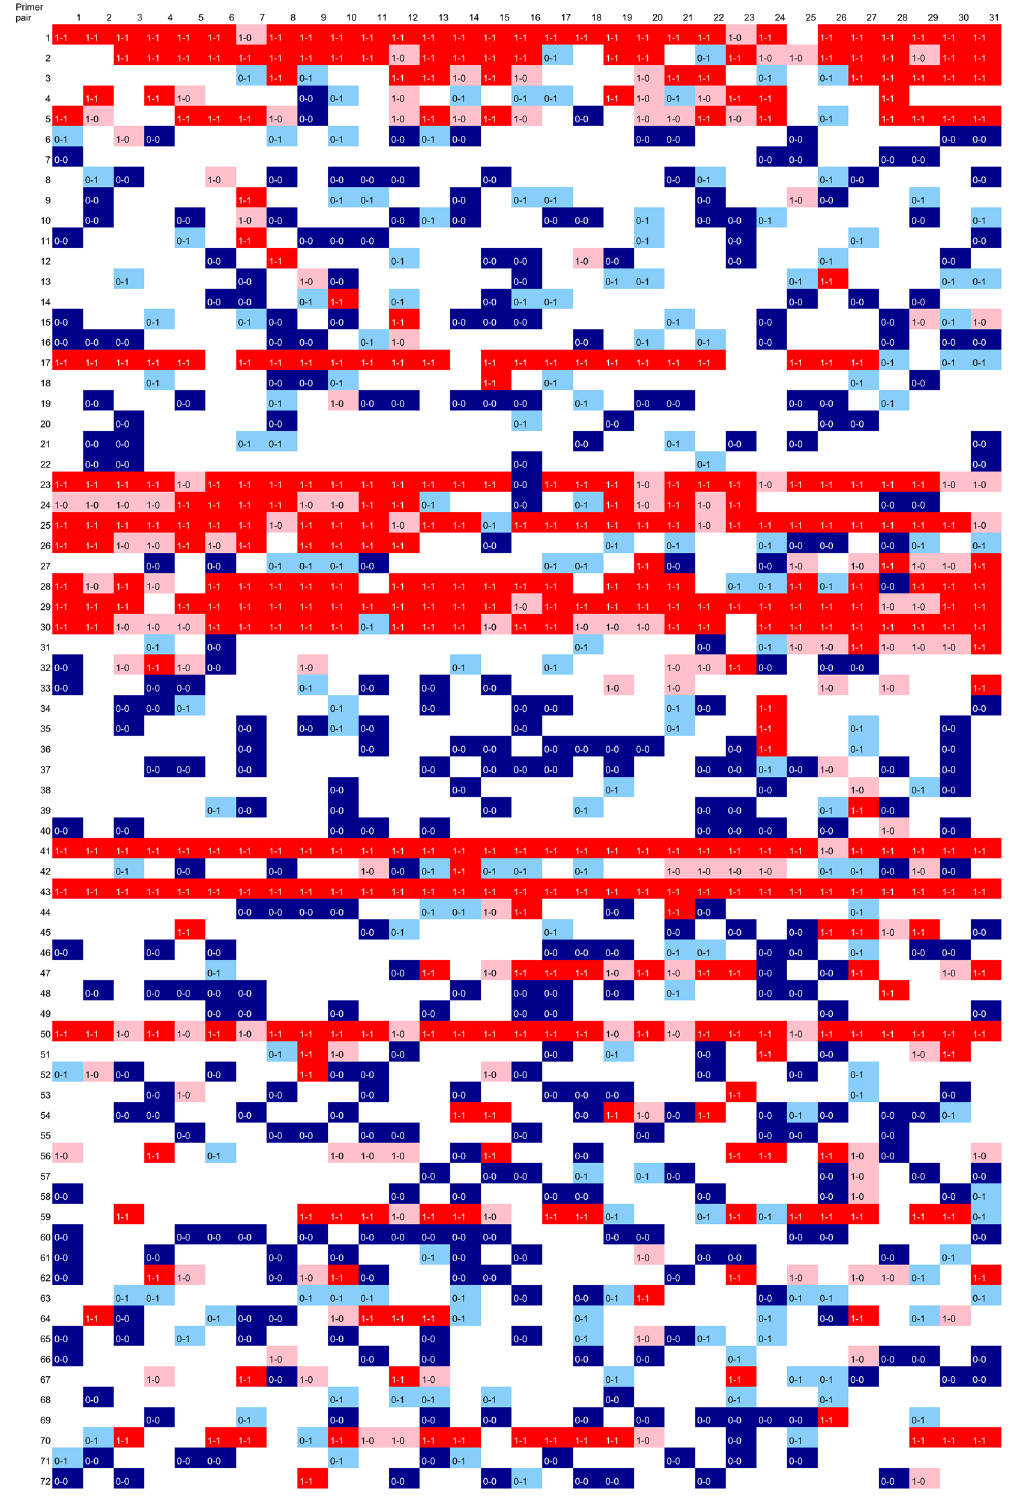
Table 7. Color summarization of PCR results and predictions, (A) predictions from whole-data, (B) predictions from undersampling data. Color presentations for PCR-result and RNN-prediction. Colors show the following results and predictions; red: PCR-positive-prediction-positive, pink: PCR-positive-prediction-negative, blue: PCR-negative-prediction-negative, light blue: PCR-negative-prediction-positive, white: primer pair-template sets excluded from predictions during